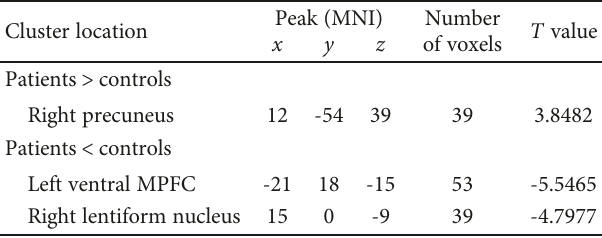
Figure 2: Statistical maps showing degree centrality di ff erences between patients and controls. Red and blue denote higher and lower degree centrality values, respectively, in the patients compared to the controls. The color bars indicate the T values of the group analysis ( P < 0 05 , GRF corrected). Table 3: Di ff erence of degree centrality in patients with CD and control